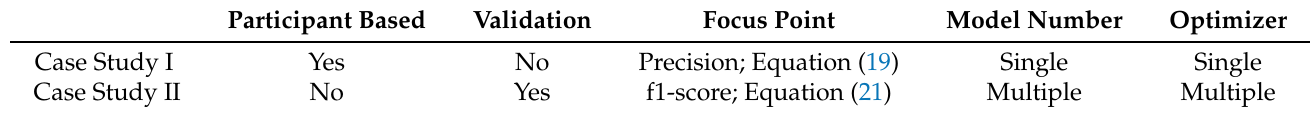
Table 1. Description of case study.